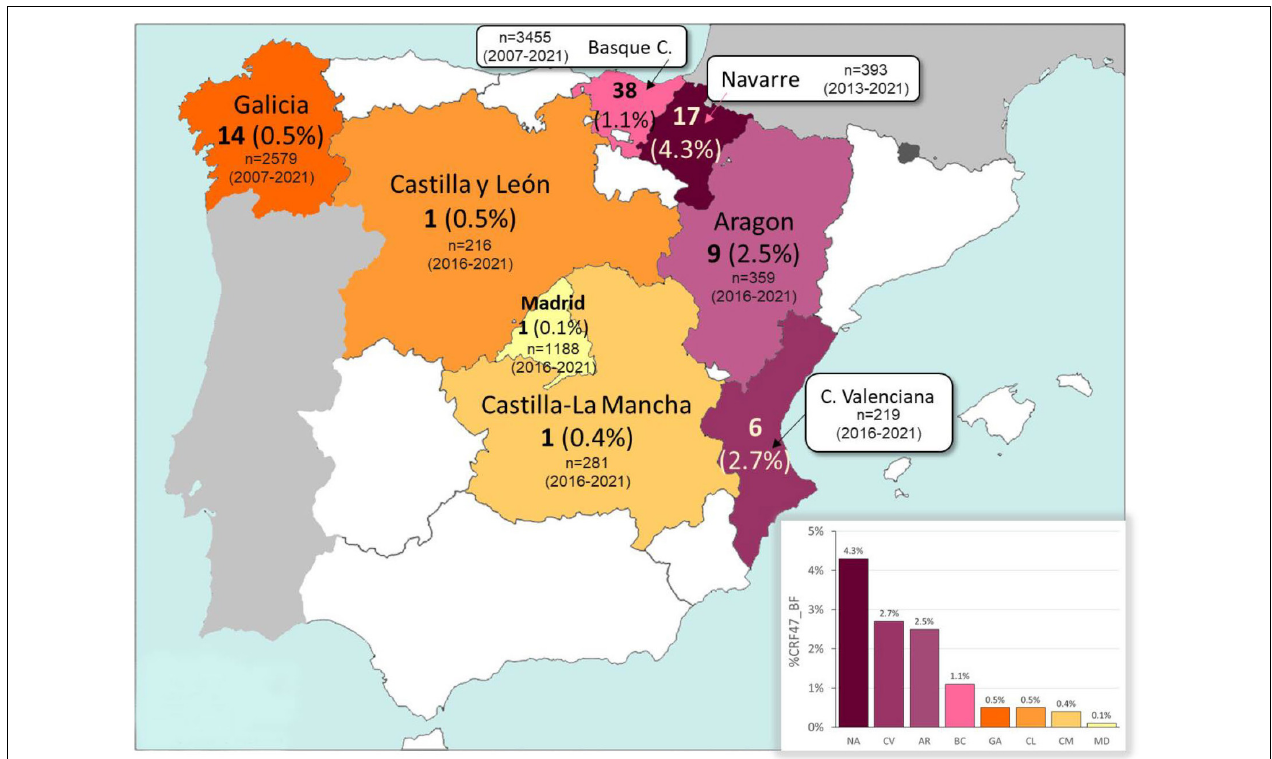
FIGURE 1 | Map of Spain with the number and estimated prevalence (percentage between parentheses) of HIV-1 CRF47_BF viruses detected in each of the eight regions analyzed. The number of new HIV-1 diagnoses ( n ) and the period of study in each region are also indicated. The percentage of CRF47_BF in each region is also represented in the inserted bar chart. NA, Navarre; CV, Comunitat Valenciana; AR, Aragon; BC, Basque Country; GA, Galicia; CL, Castilla y León; CM, Castilla-La Mancha; MD, Madrid.